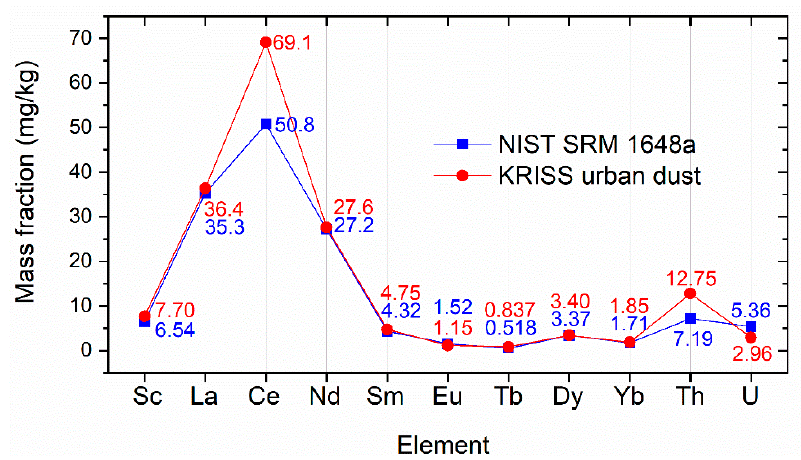
Figure 5. Comparison of mass fractions of REEs, U, and Th in NIST SRM 1648a urban PM and KRISS urban dust CRM candidate.